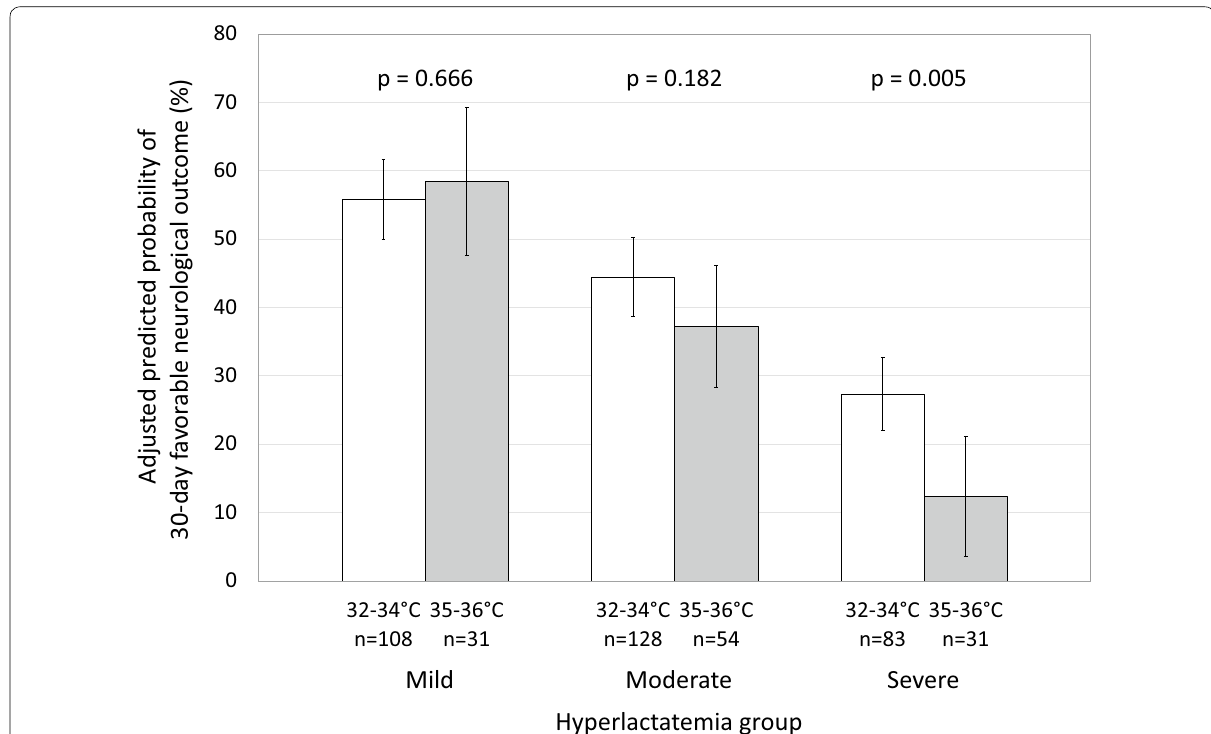
Fig. 2 Adjusted predicted probability of favorable 30-day neurological outcomes of 32–34 °C and 35–36 °C among patients in the three hyperlactatemia group. Error bars indicate 95% confidence intervals. p for interaction